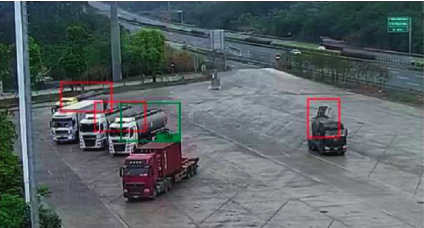
Figure 12: Detection failure